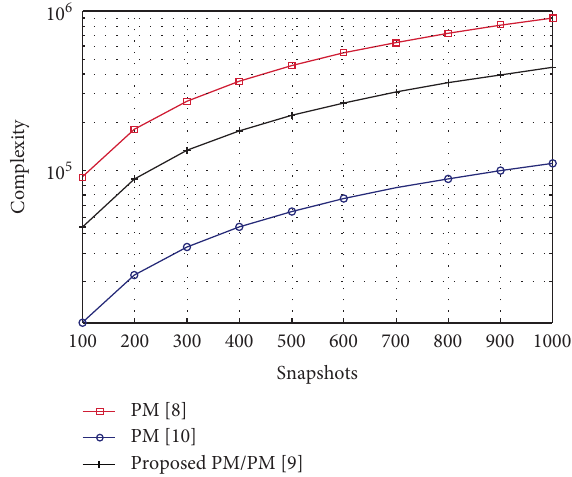
Figure 4: Complexity versus snapshots.